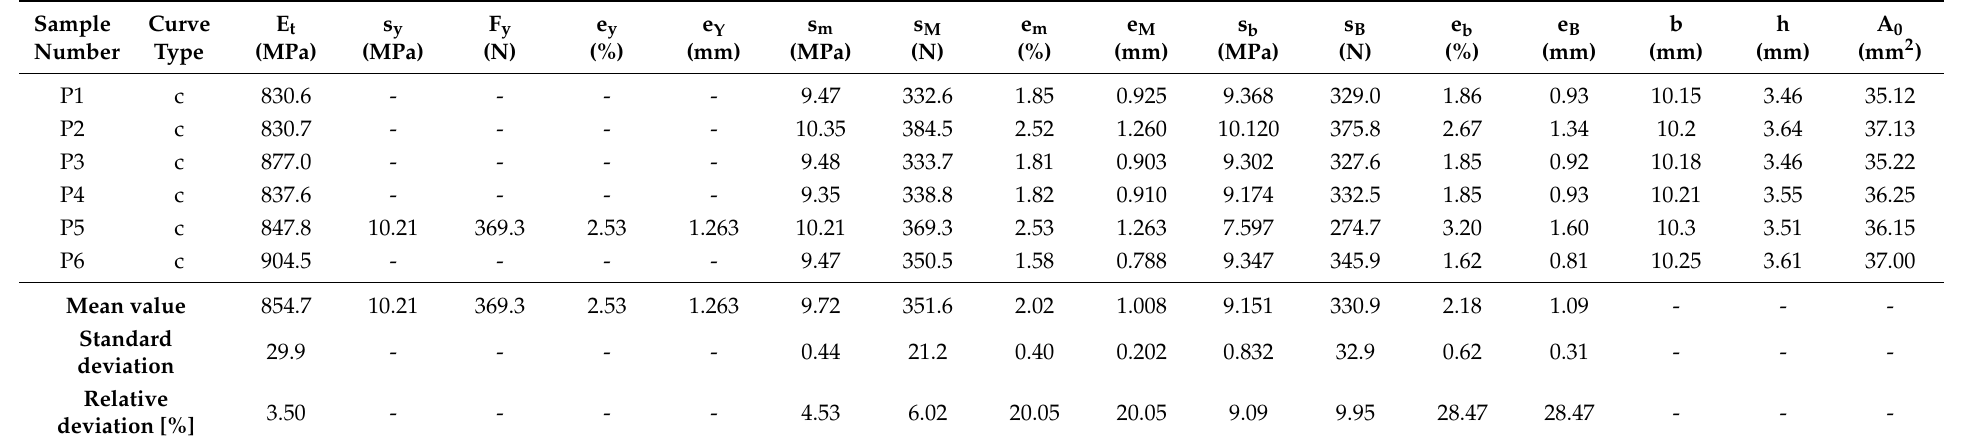
Table A42. Results of the tensile tests of PO_B.